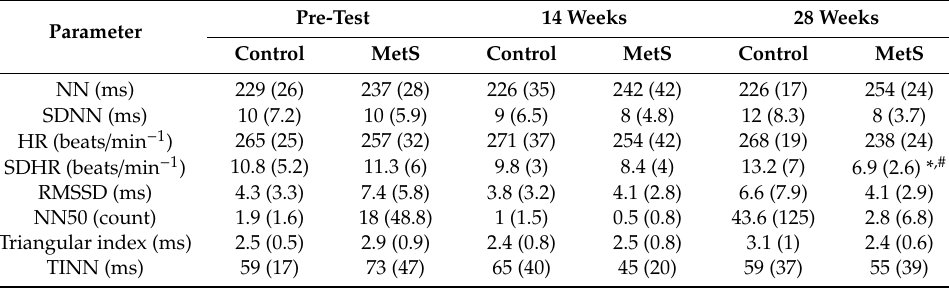
Table 1. Time-domain parameters of short-term heart rate variability (HRV)